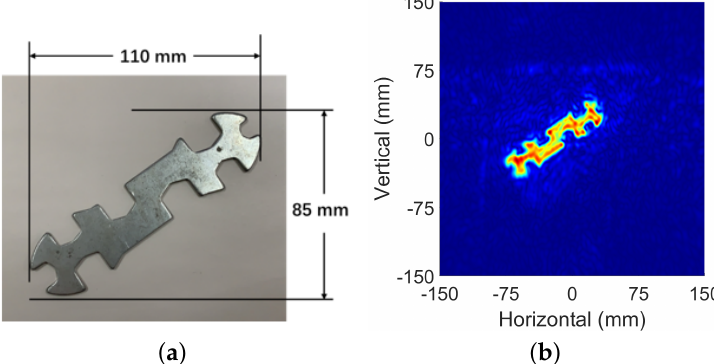
Figure 11. Image target: ( a ) optical image; ( b ) reconstruction results of the SAR data where d x = 0.91 d y = 1 mm.